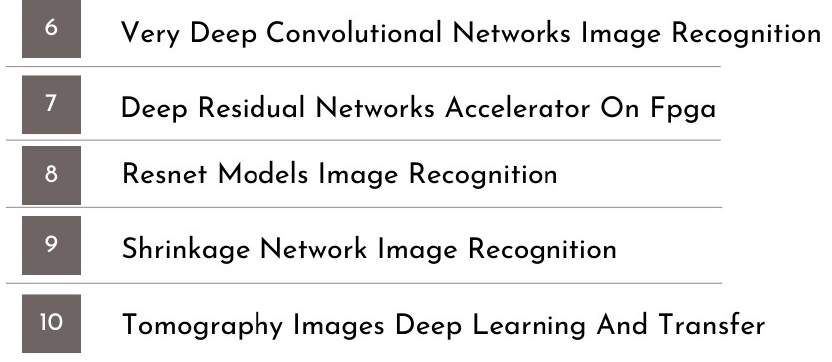
Figure 6. Next Five Topics.